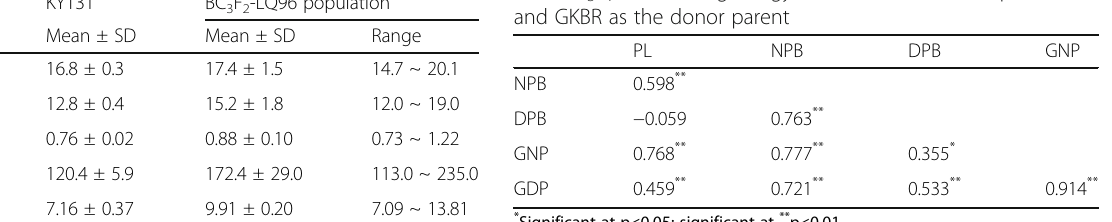
Table 2 Correlation coefficients of the five yield-related traits investigated in the random subpopulation BC 3 F 2 -LQ96 derived from BC 3 F 1 -22F01 using Kongyu 131 as the recurrent